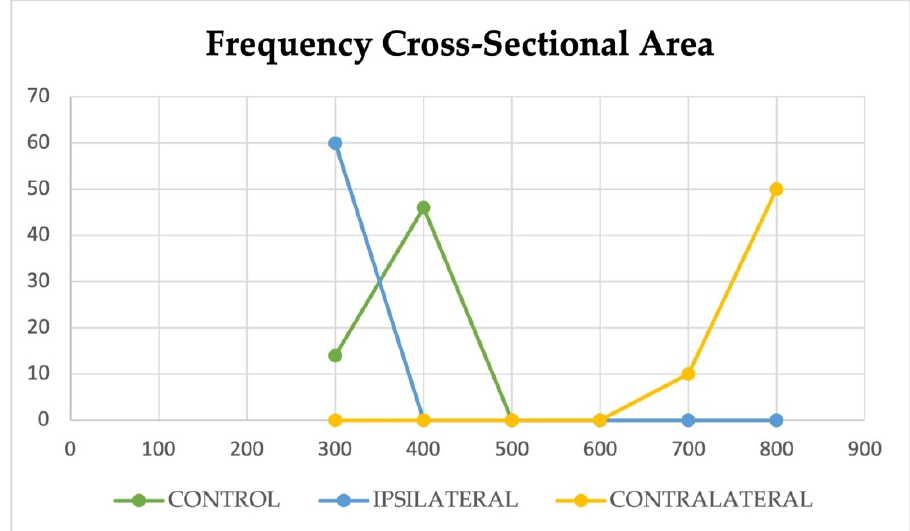
Figure 5. The graphic shows the frequency of cross-sectional area values. The y-axis shows the number of fibers and the x-axis shows the ranges of cross-sectional area values expressed in μ m 2 . Most of the cross-sectional area values are between 300 and 400 μ m 2 for the control group, between 200 and 300 μ m 2 for the ipsilateral muscle (crossbite group) and between 700 and 800 μ m 2 for the contralateral muscle (crossbite group).